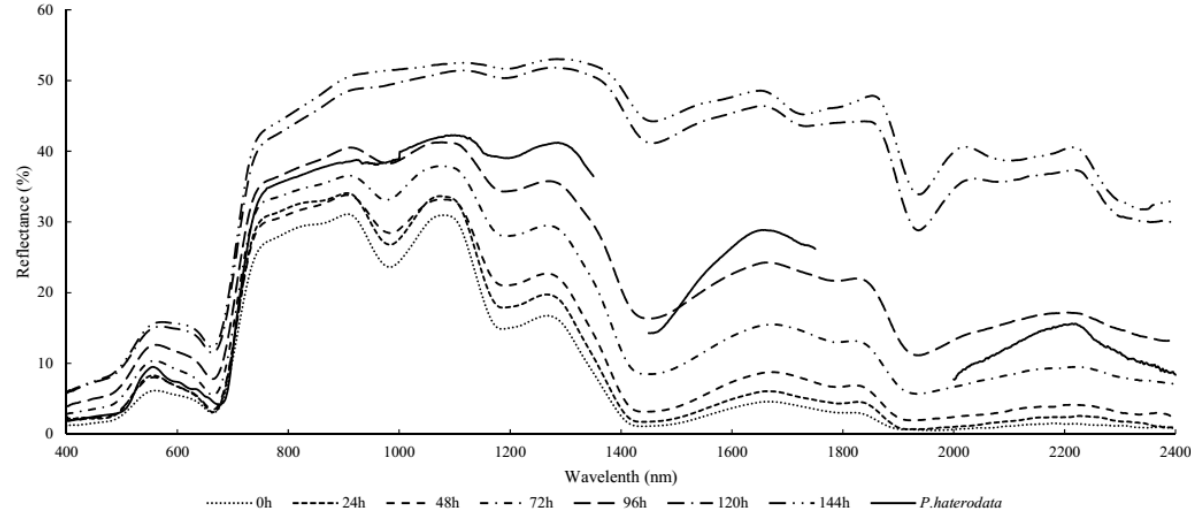
Figure 11. The variation of spectral reflectance with water content in S. magellanicum